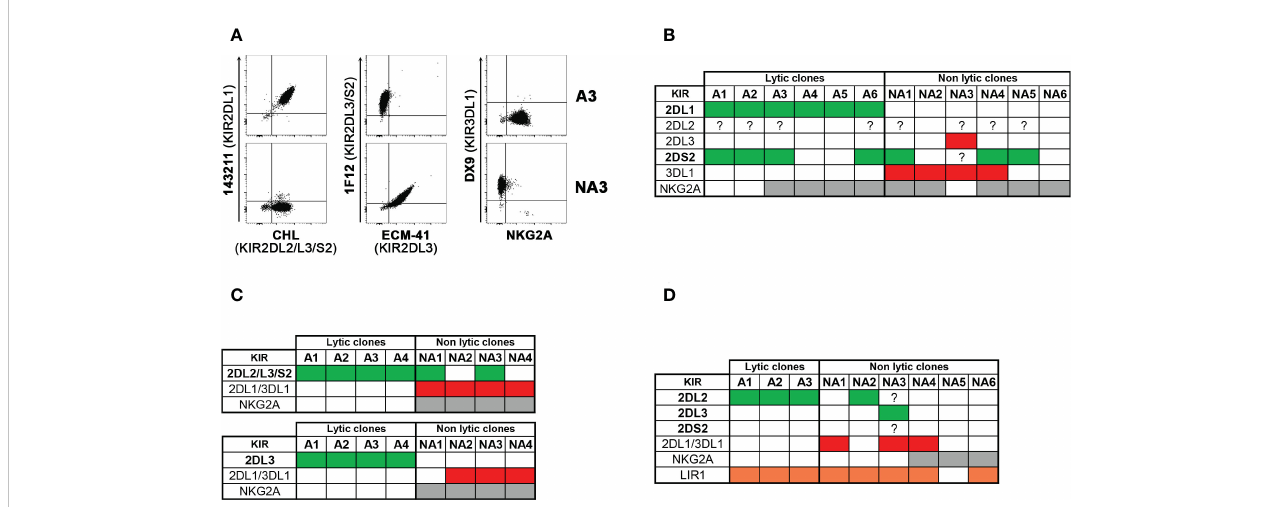
FIGURE 6 Cyto fl uorimetric analysis of lytic versus non lytic NK cell clones. NK cell clones derived from four donors, selected to be lytic (alloreactive, A) and non-lytic (non-alloreactive, NA) against the related patient PHA-blasts were analyzed, by fl ow cytometry, for the expression of relevant KIRs, NKG2A, and in one case LIR1. Considering the type of alloreactivity, the presence of the permissive iKIR(s) and relevant aKIR are written in bold and indicated as green, the blocking iKIR(s) as red, NKG2A as grey, and LIR1 as orange boxes, while their absence as white boxes; a question mark indicates uncertainty due to the lack of mono- speci fi city of certain mAbs (i.e., GL-183, CH-L and 1F12). Representative stainings (A) and cumulative data (B) of clones derived from D of patient #10 (Allo C2). (C) summary of clones from D1 (up) and D2 (bottom) of patient #11 (Allo C1). (D) summary of clones from D of patient #16 (Allo